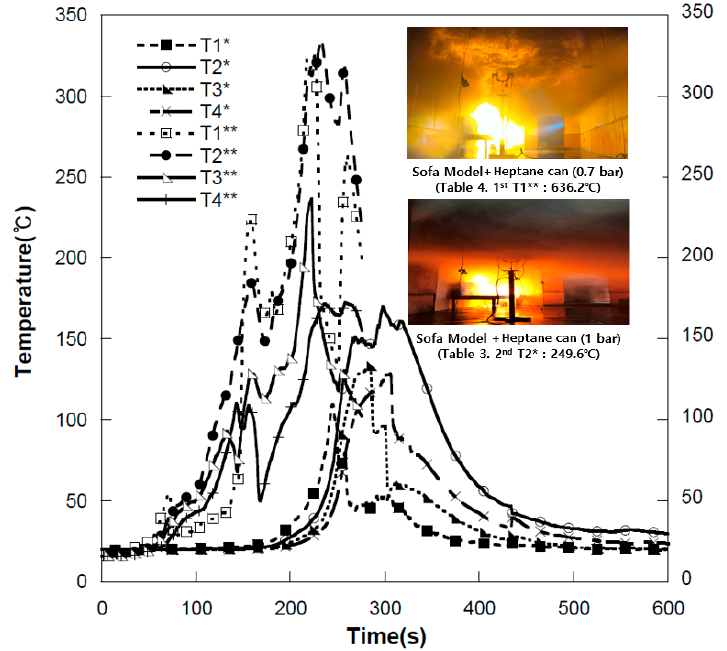
Figure 12. Comparison of the average heat air current temperatures around the ceiling in fire tests of the fuel package for multiplexes according to discharge pressure (*: 1 bar (0.1 MPa); **: 0.7 bars (0.07 MPa)).